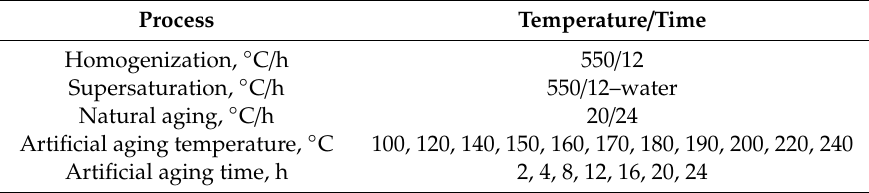
Table 3. Parameters of homogenization, supersaturation and artificial aging.